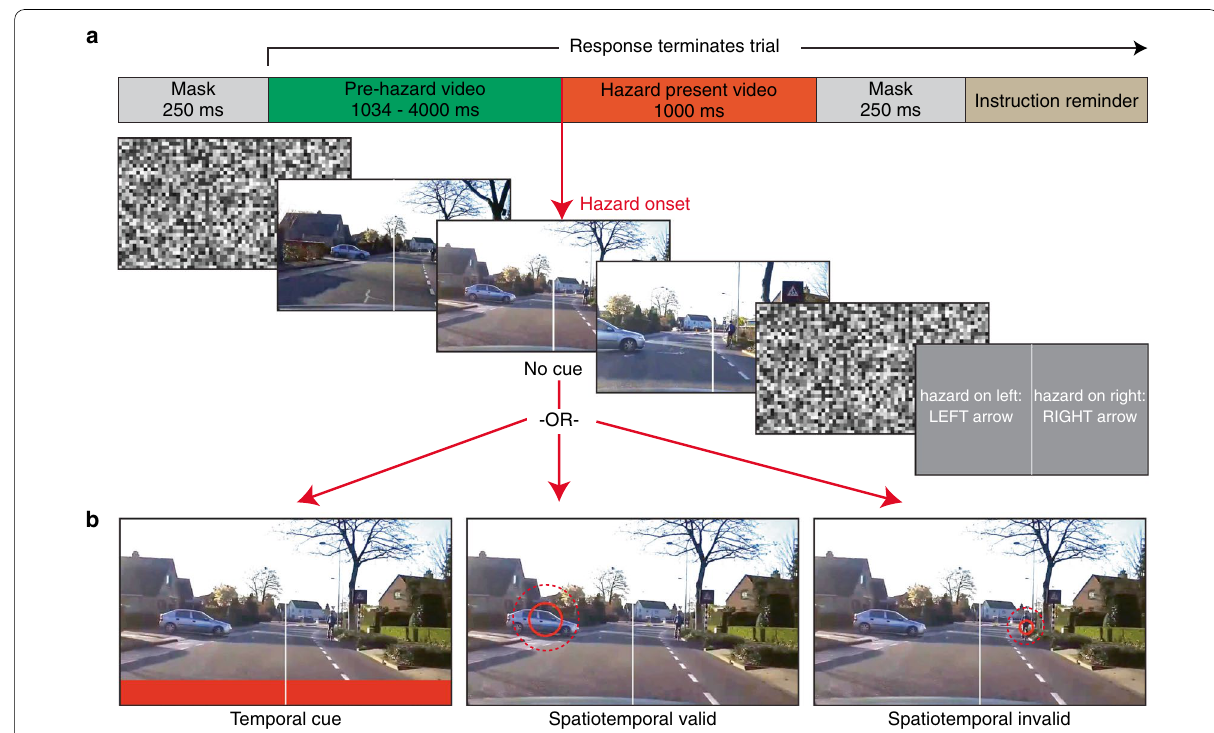
Fig. 1 Visualization of trial sequence and cues. a Each trial began with a random noise mask for 250 ms, and consisted of a video that lasted between 2034 and 5034 ms. In a given video, the hazard could appear between 1034 and 4000 ms after the video began. The portion of the video containing the hazard was always 1000 ms long, and was followed by a 250 ms random noise mask. Participants were instructed to use the left and right arrow keys to indicate the lateral location of the hazard, and could respond any time after the video started. b The video contained either no cue or one of three cues: a temporal cue (red bar at the bottom of the video), a spatiotemporal valid cue (expanding ring superimposed on the hazard, represented by the solid red circle and the larger dashed red circle) and a spatiotemporal invalid cue (expanding ring superimposed on a nonhazardous object in the scene). The no-cue, temporal cue, and spatiotemporal conditions were blocked, and block order was randomized across participants. Within the spatiotemporal cue block, valid and invalid spatiotemporal cues were randomly interleaved and appeared with equal frequency (50% cue validity). The expanding ring spatiotemporal cue was chosen using the procedure described in the “Cue selection”